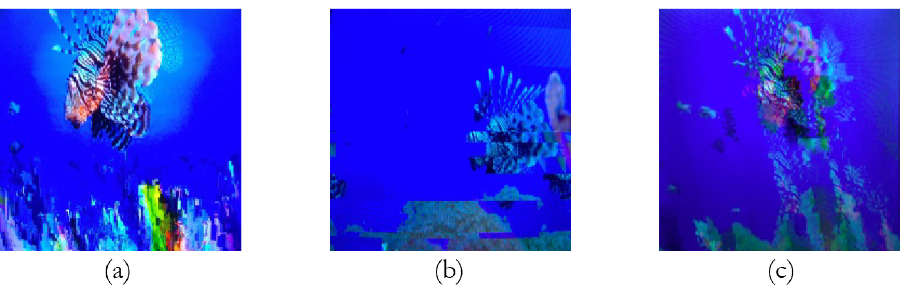
Figure 2. Examples of anomalous frames showing the real mosaic ( a ) and the simulated mosaic in the 60frames ( b ) and DenserGlitch ( c ) datasets,